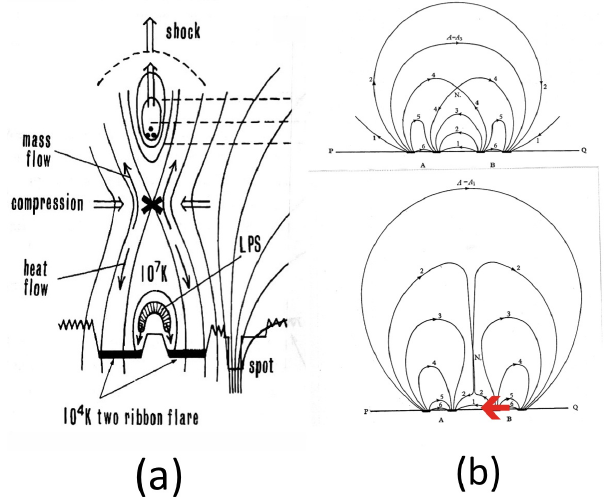
Figure 1. (a) Magnetic reconnection model in the corona above a magnetic arcade (Hirayama, 1974). (b) Two approaching sunspot pairs, forming an antiparallel magnetic field configuration (Sweet, 1958); a red arrow is added to show the motion of a sunspot